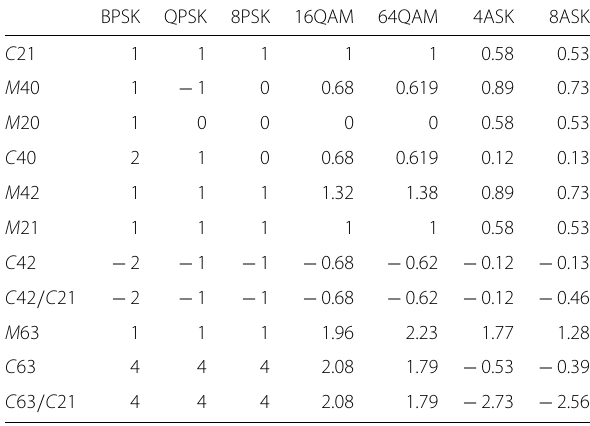
Table 1 Theoretical value of some HOMs and HOCs without noise